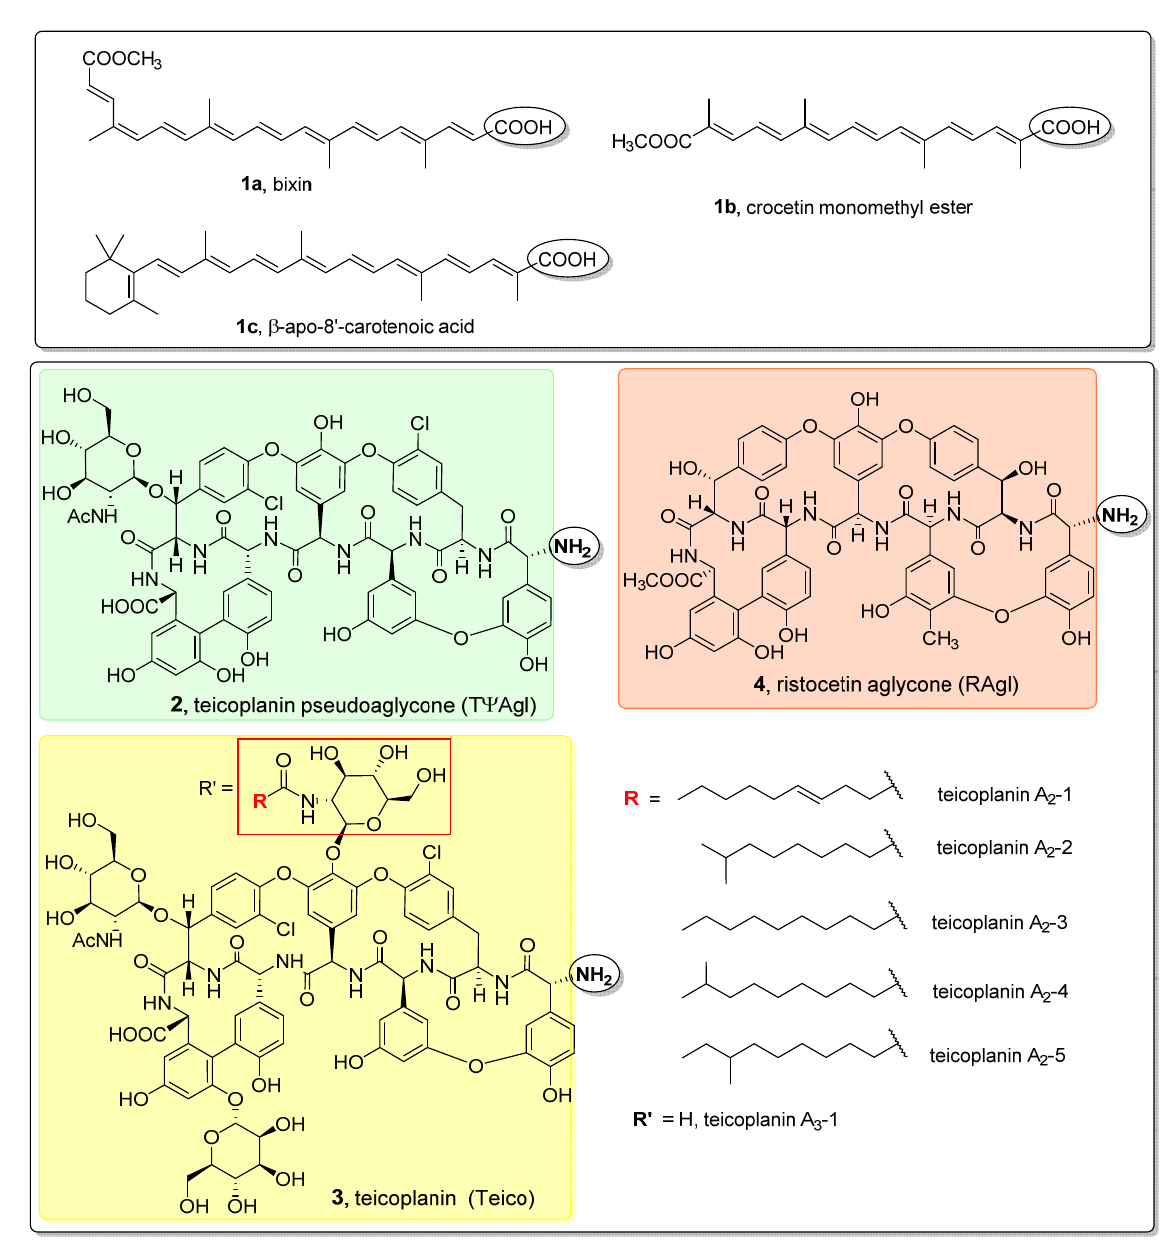
Figure 2. Apocarotenoids (top panel) and glycopeptide antibiotic derivatives (bottom panel) used for the synthesis of the glycopeptide conjugates. The functional groups involved in the conjugation reactions are marked with a circle.